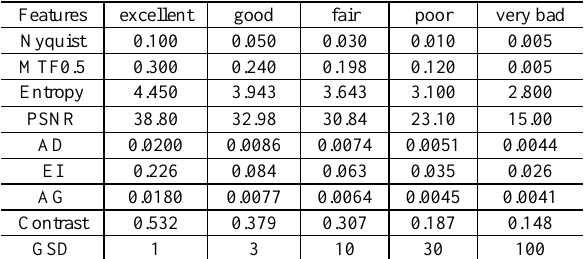
Table 2. The fuzzy evaluation threshold table